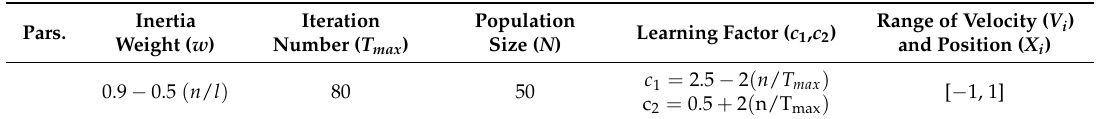
Table1. The parameters (Pars.) setting for PSO algorithms.